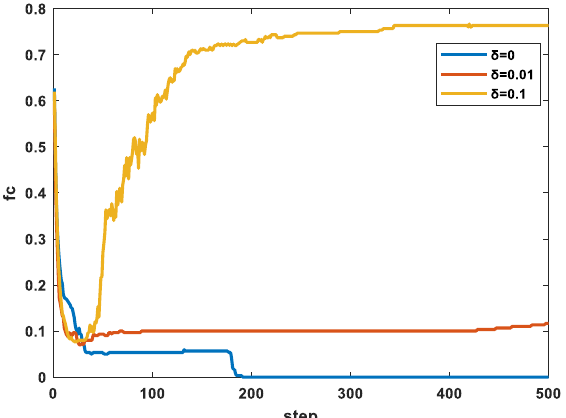
Figure 4. Time evolution of system cooperation level with different weight intensity δ.